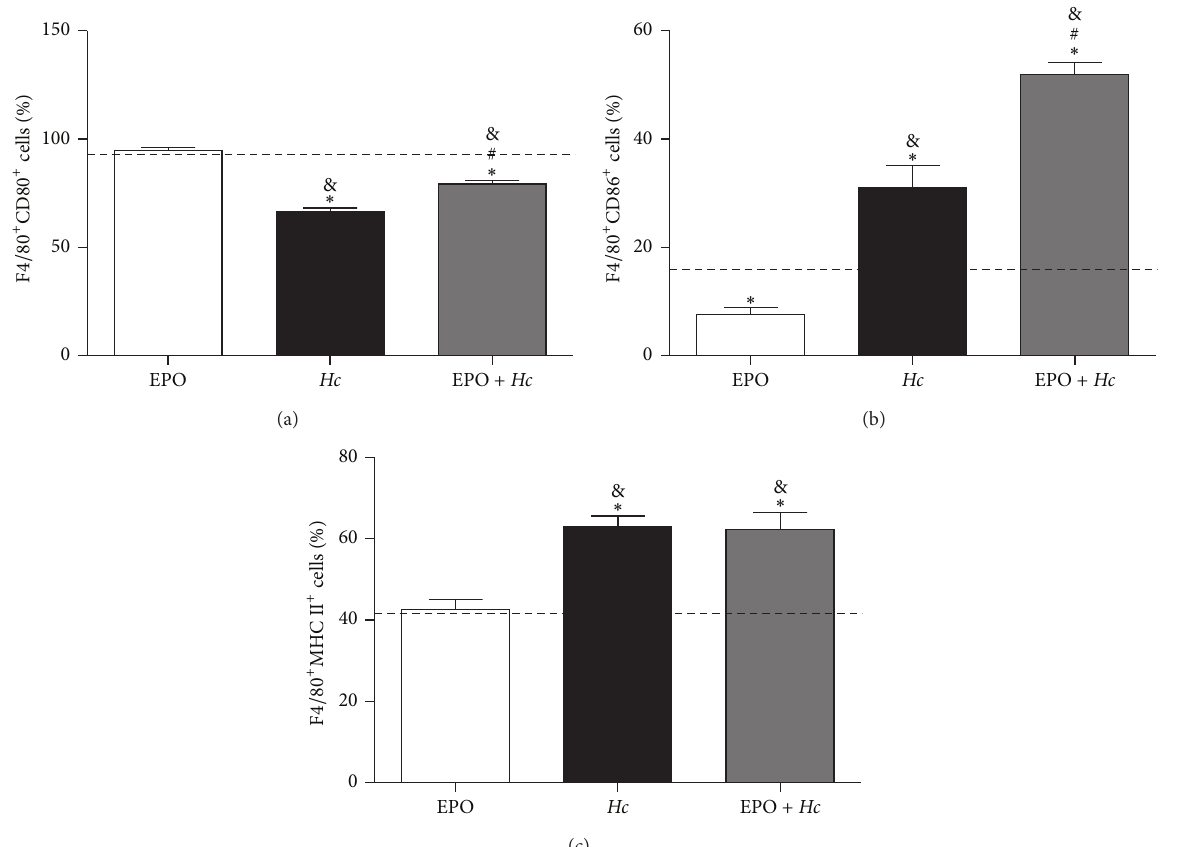
Figure 4: EPO pretreatment alters the expression of macrophage activation markers in Hc -infected mice. 14 days after infection, BALF cell populations from uninfected mice EPO-treated (EPO) and from untreated ( Hc ) or EPO pretreated ( EPO + Hc ) mice infected with Hc (5 × 10 5 yeasts/100 𝜇 L/mouse) were analyzed by flow cytometry for the percentage of F4/80 + CD80 + (a), F4/80 + CD86 + (b), and F4/80 + MHC II + (c) cells. Means ± SEM values from one representative of two independent experiments are shown ( 𝑛 = 4 –6). Newman-Keuls multiple comparison test was used and the differences were considered significant when 𝑝 < 0.05 . # Versus Hc ; ∗ versus uninfected and EPO-untreated (dashed line); & versus uninfected and EPO-treated